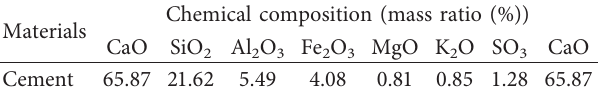
Table 1: Main components of cement.